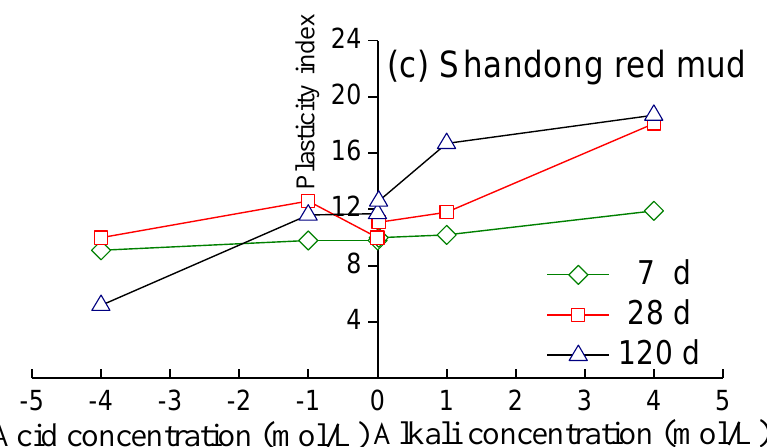
Figure 3. ChangesintheplasticityindexasafunctionoftheHClorNaOHsolutionconcentration—( a )Shanxi Figure 3. Changes in the plasticity index as a function of the HCl or NaOH solution concentration — silty soil, ( b ) Shanxi red mud, and ( c ) Shandong red ( a ) Shanxi silty soil, ( b ) Shanxi red mud, and ( c ) Shandong red mud.